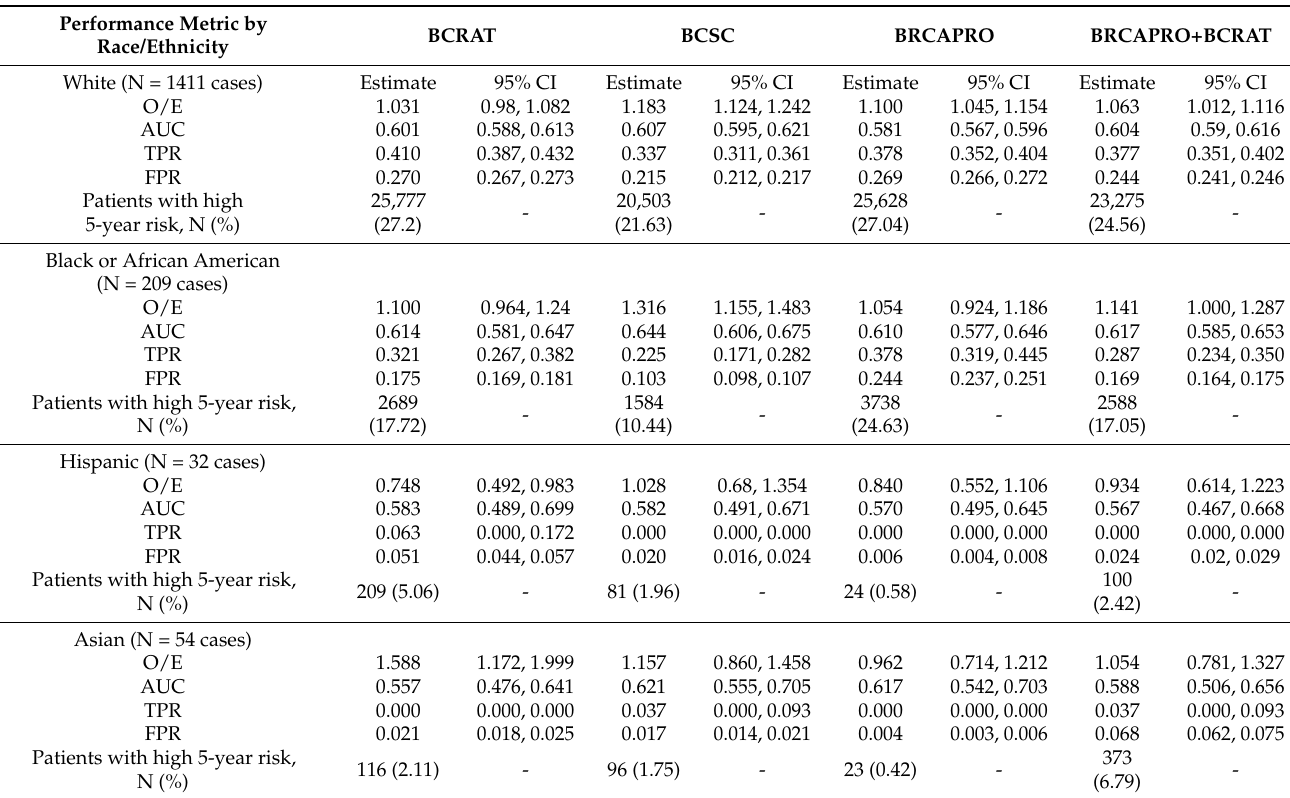
Table 3. Performance of risk models by race/ethnicity 1